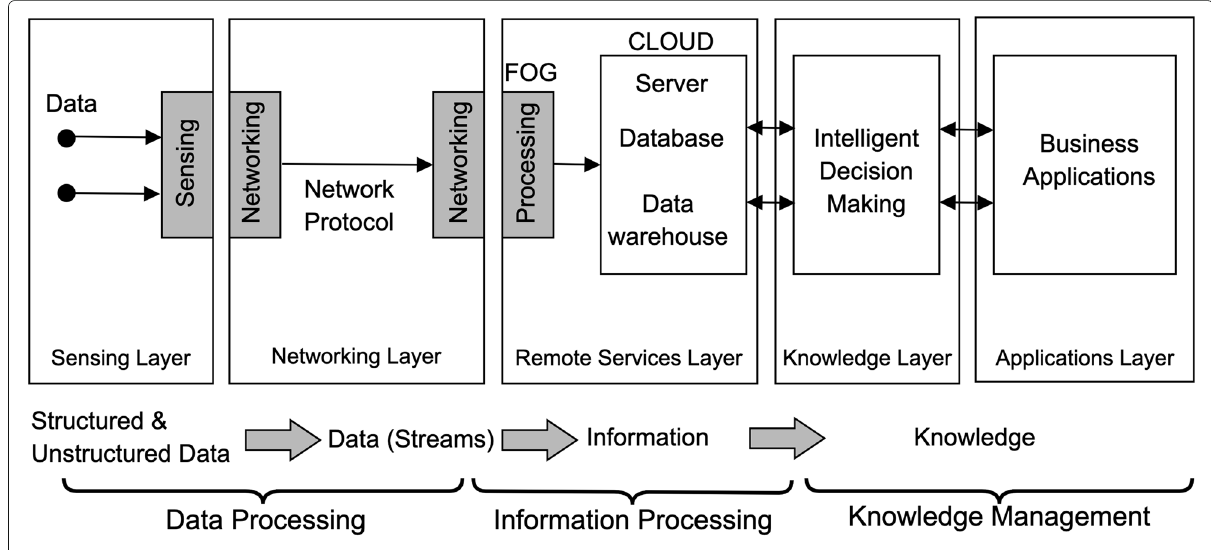
Fig. 2 Transformation of raw data into meaningful knowledge based on IoT